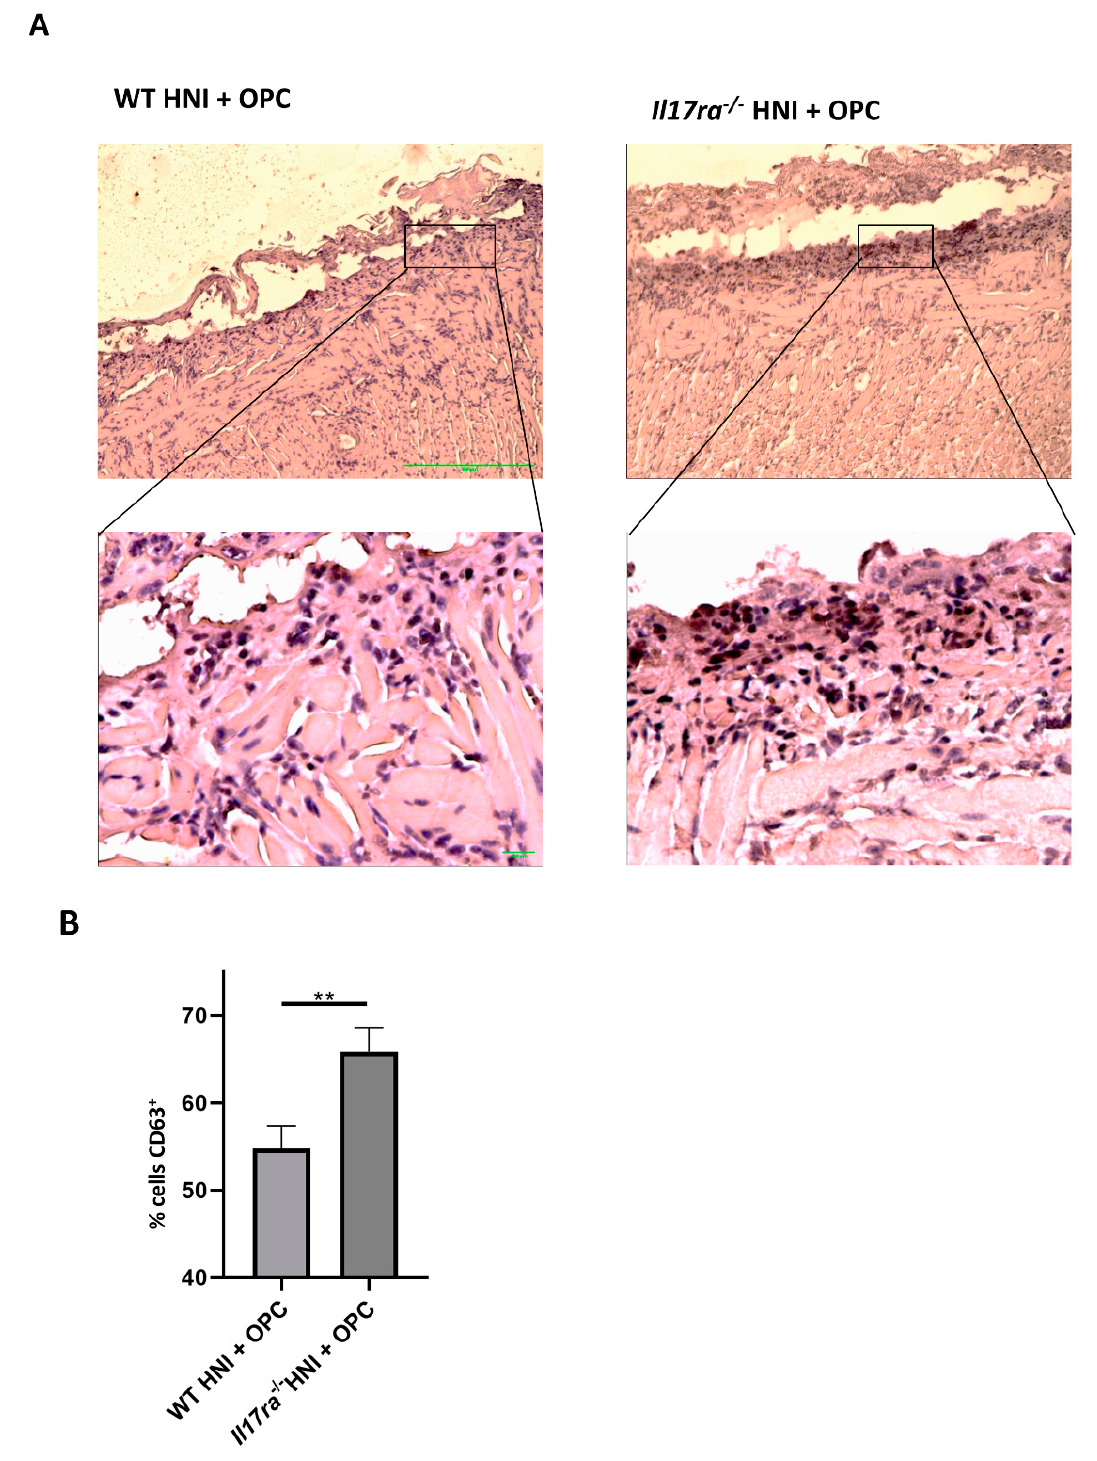
Figure 9. Enhanced CD63 expression in irradiated tongue tissue in the absence of IL-17RA. ( A ) Representative immunohistochemical staining for CD63 in the ulcer boundary region counterstained with hematoxylin. Images representative of 2 mice per group. Top Images taken at 10 × magnification, bottom images taken at 40 × magnification. ( B ) CD63+ neutrophil quantification analyzed by Student’s t -test. Each data point represents the number of CD63+-stained neutrophils in 10 fields of view for each mouse (n = 2 mice per group). Evaluators blinded to the treatment group and mouse cohort analyzed the tissue sections. (** p < 0.01).